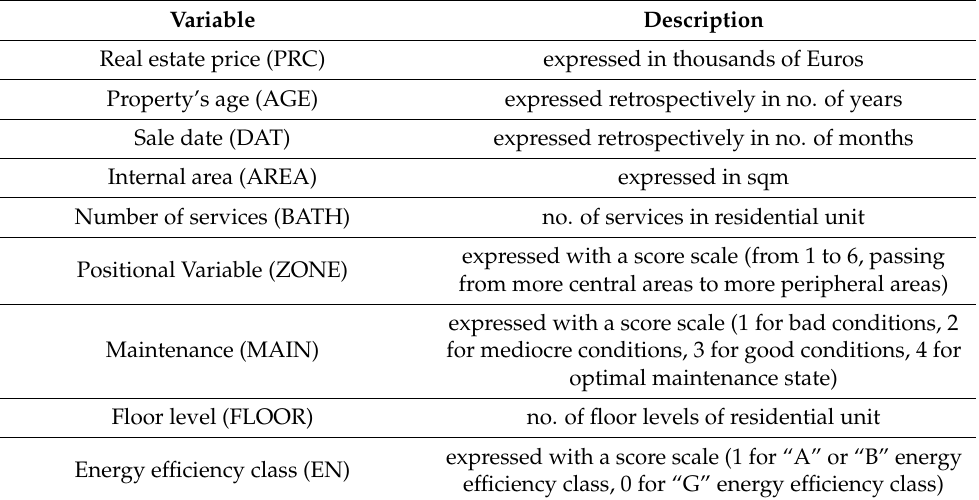
Table 1. Variable description.